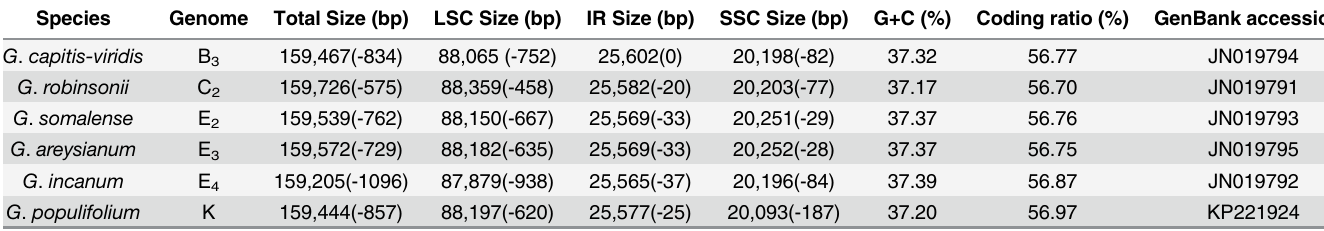
Table 1. General features of six Gossypium chloroplast genomes.